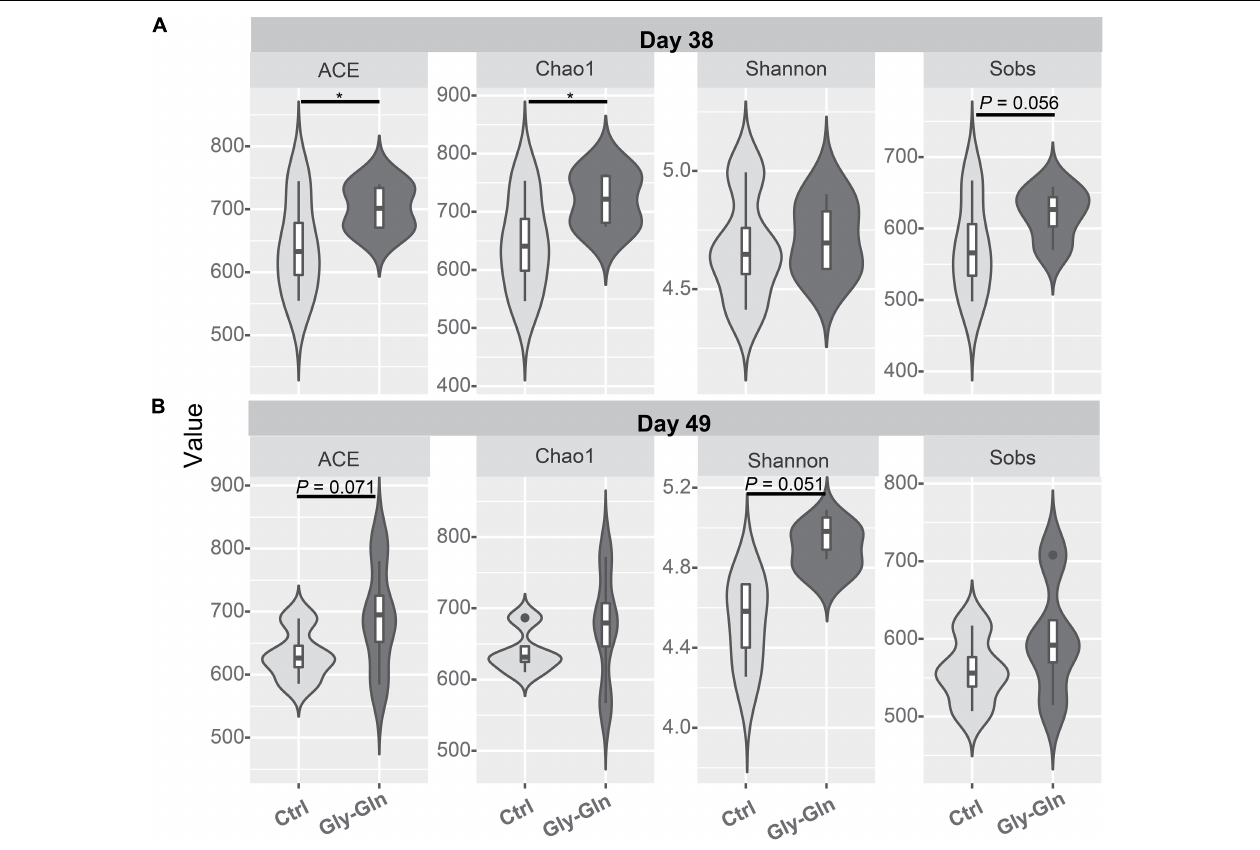
FIGURE 2 | Effects of dietary Gly-Gln supplementation on alpha diversity of the gut microbiota in piglets. The alpha diversity indices ACE, Chao1, Shannon, and Sobs on day 38 (A) and day 49 (B) respectively. Significance was presented as ∗ P < 0.05, whereas P values between 0.05 and 0.10 were considered as indicative of a trend ( n =